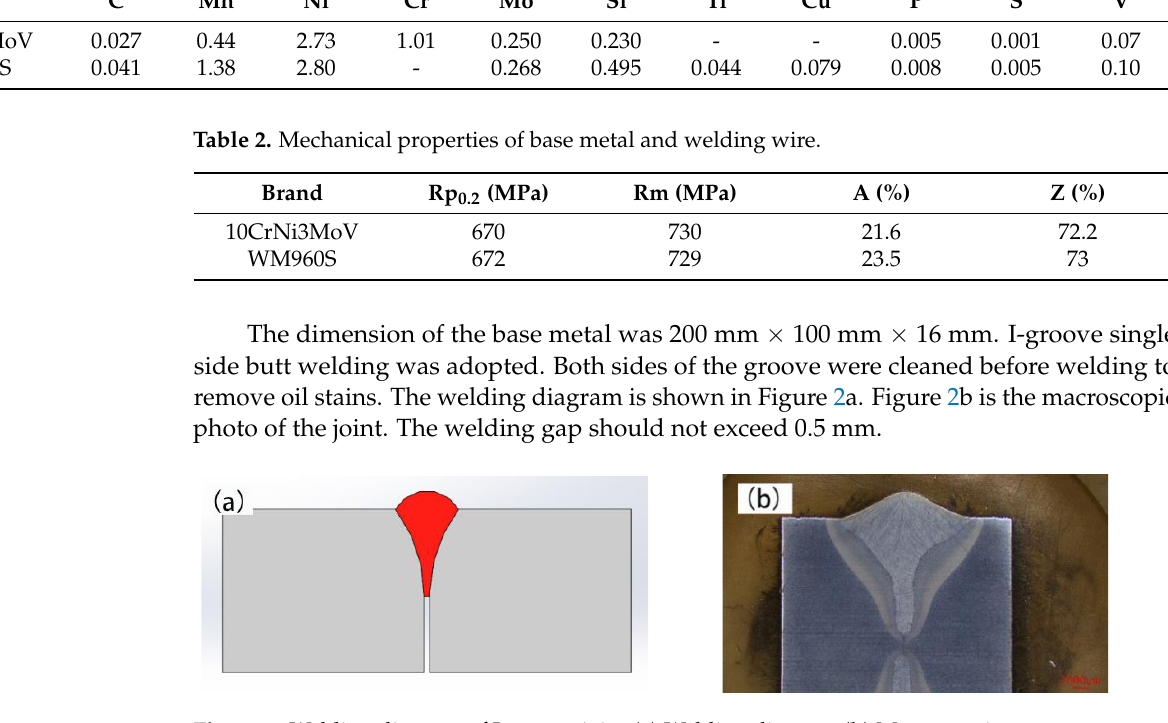
Figure 2. Welding diagram of I-groove joint ( a ) Welding diagram ( b )